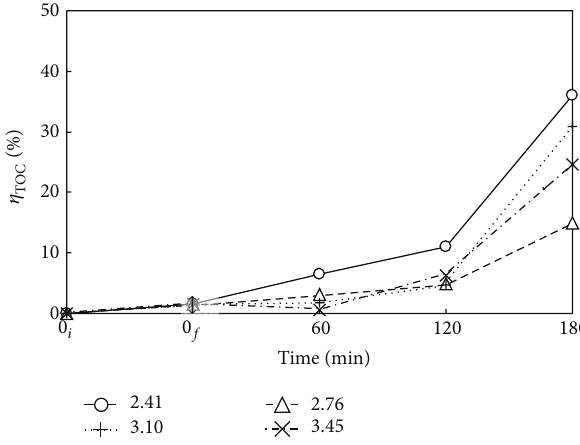
Figure 8: Time variation of 𝜂 TOC via WOP at various pressures. I , −1 , 𝑉 𝐶 △ , +, and × : 𝑃 𝑇 = 2.41, 2.76, 3.10, and 3.45 MPa. 0 = 100mg L 𝐿 = 400 mL, 𝑇 = 483 K, and Nr = 500 rpm. Working gas after time = 0 𝑓 is O 2 . ↕ : Mean and Standard deviation (SD, 𝑛 − 1 method) at 𝑡 = 0 𝑓 : 1.5 ±